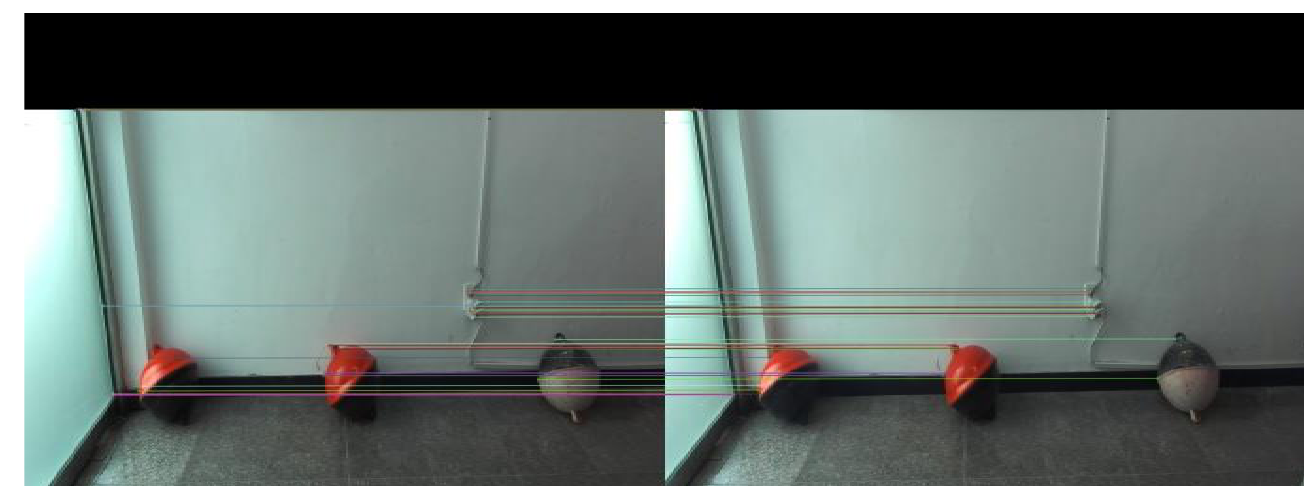
Figure 15. Area-based stereo matching results (Experiment A): ( a ) SSD and ( b ) NCC.